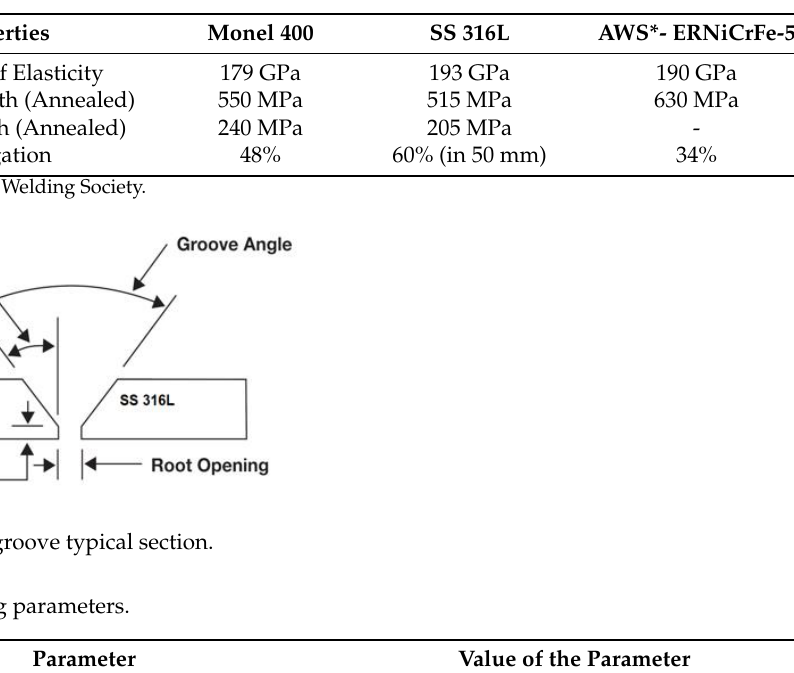
Table 2. Material properties.